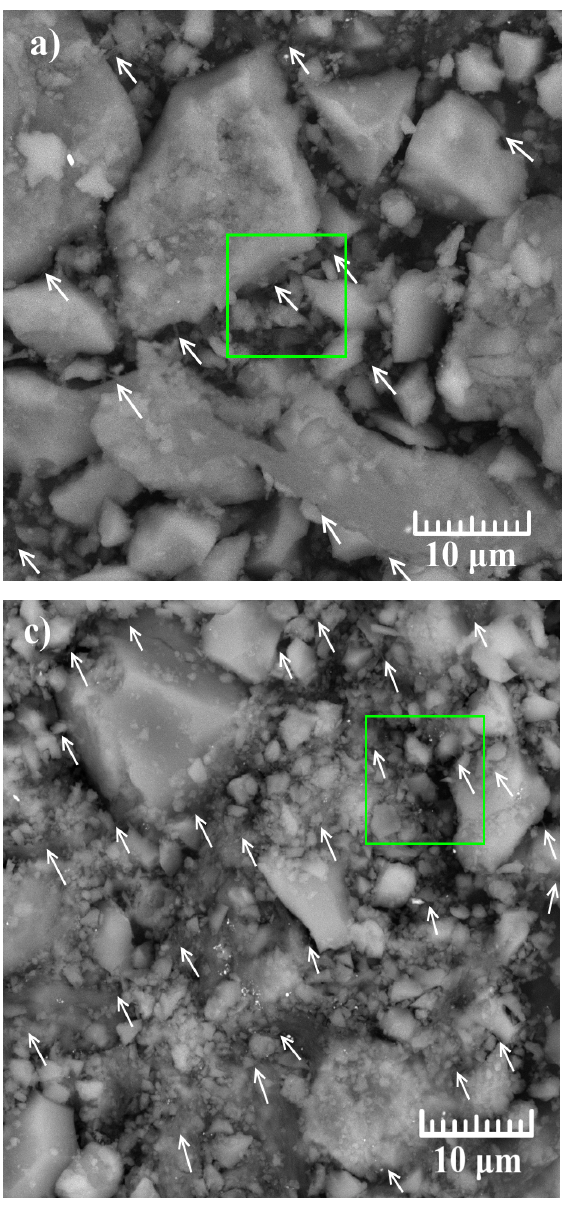
Figure 4. SEM images of the MgH 2 –5 wt.% SWCNT composite obtained after 120 min ( a , b ) and 180 min ( c , d ) of ball milling at a speed of 300 rpm. Rectangular areas marked by green lines indicate the area of the next SEM image; white arrows mark individual distributed nanotube bundles.